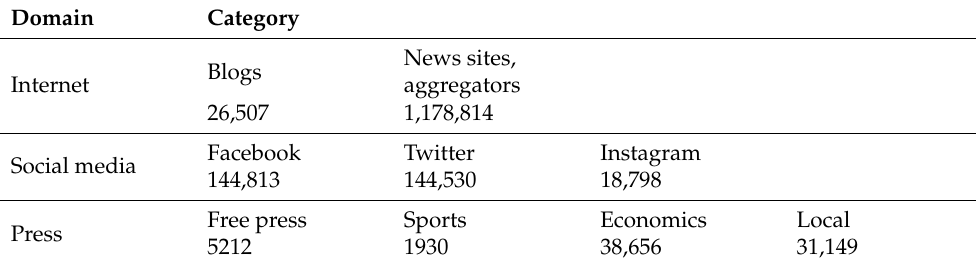
Table 1. Alignment (domain adaption) dataset statistics.